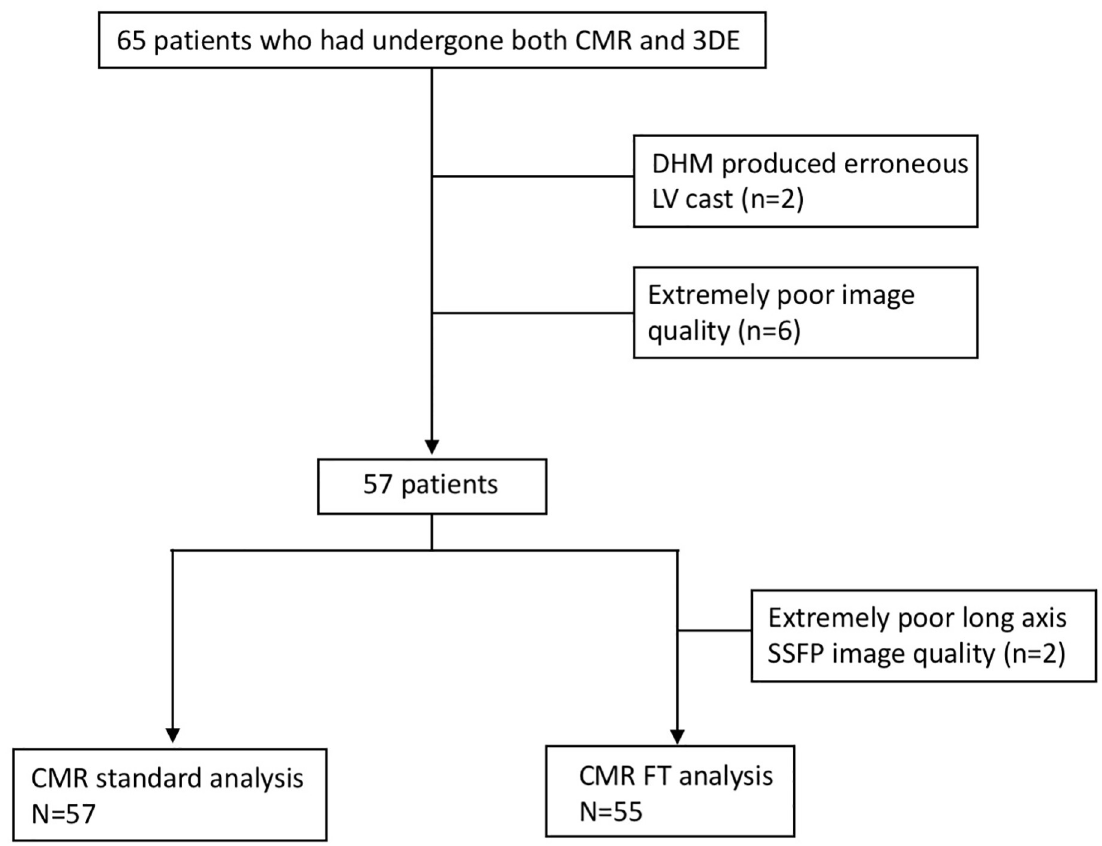
Fig 1. Flow chart of the study population. 3DE, three-dimensional echocardiography; CMR, cardiac magnetic resonance; DHM, Dynamic HeartModel; LV, left ventricular.